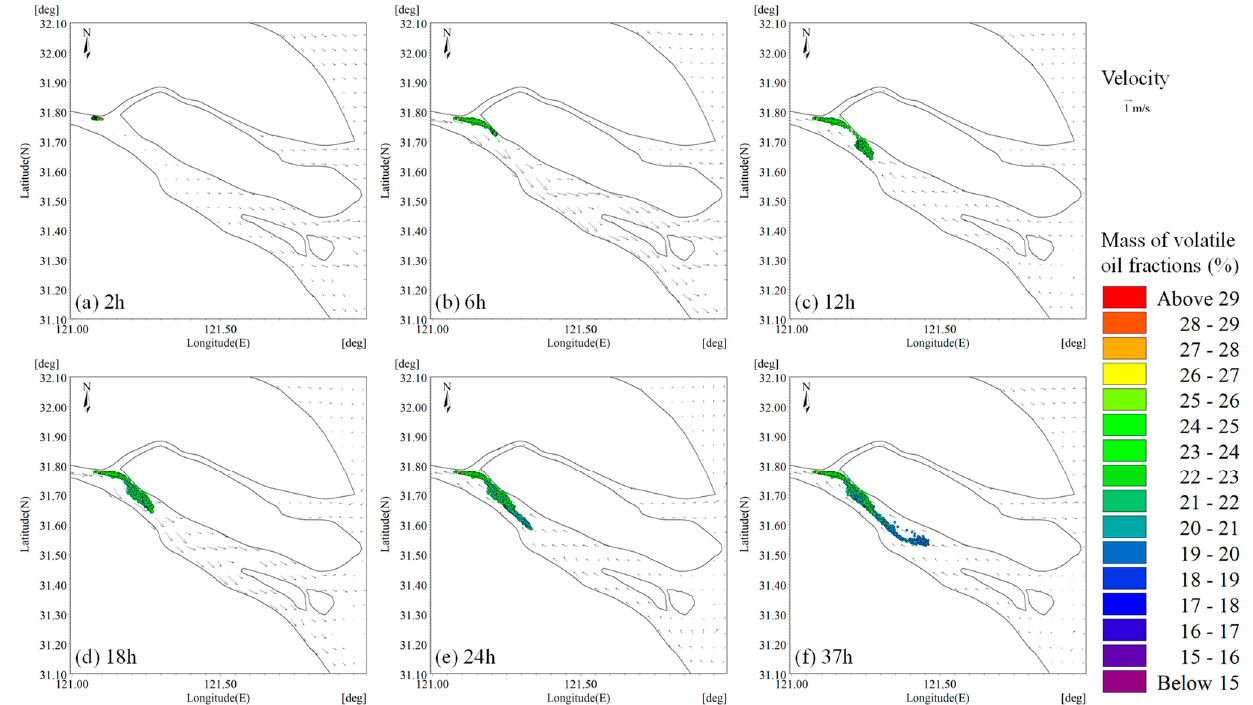
Figure 7. ( a – f ) Time evolution of oil particle track within 37 h starting at 23:00 on 19 September 2014 before Typhoon Fongwong affected the YRE. The color of circles indicates the mass of volatile oil fractions whose weight is below 160 g/mol, boiling point well below 300 deg C.